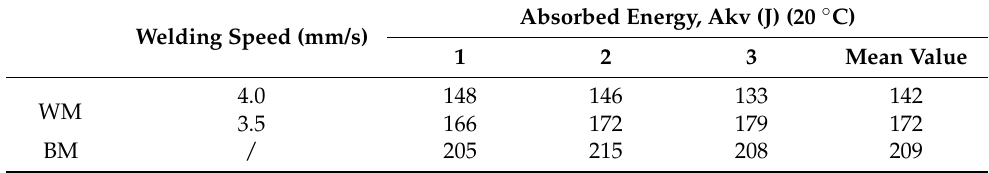
Table 4. Absorbed energy of the BM and WM.